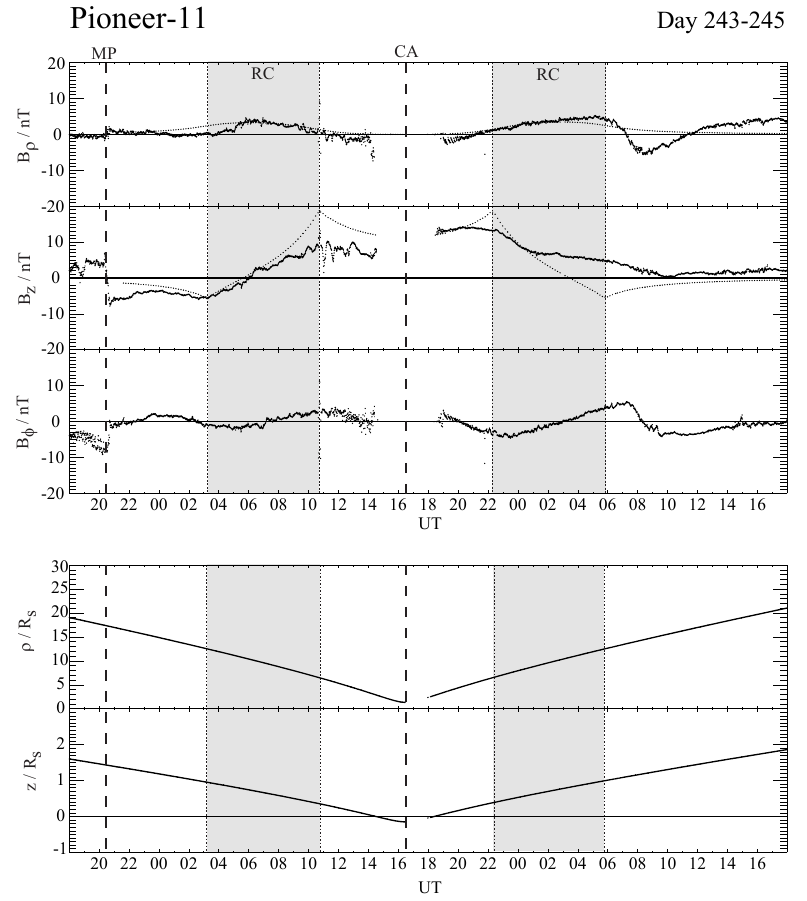
Fig. 5. Plot showing magnetic field and position data for the Pioneer-11 fly-by of Saturn, in the same format as Fig. 3. Data for two (Earth) days are again shown, corresponding to the interval from 18:00UT on day 243 to 18:00UT on day 245 of 1979. The fitted ring current model has parameters R 1 = 6 . 5 R S , R 2 = 12 . 5 R S , D = 2 R S , and µ 0 I 0 ≈ 76 . 5nT, as discussed in the text. Only one magnetopause crossing took place inbound at a spherical radial distance of 17 R S , and the closest approach occurred at a spherical radial distance of 1.35 R S